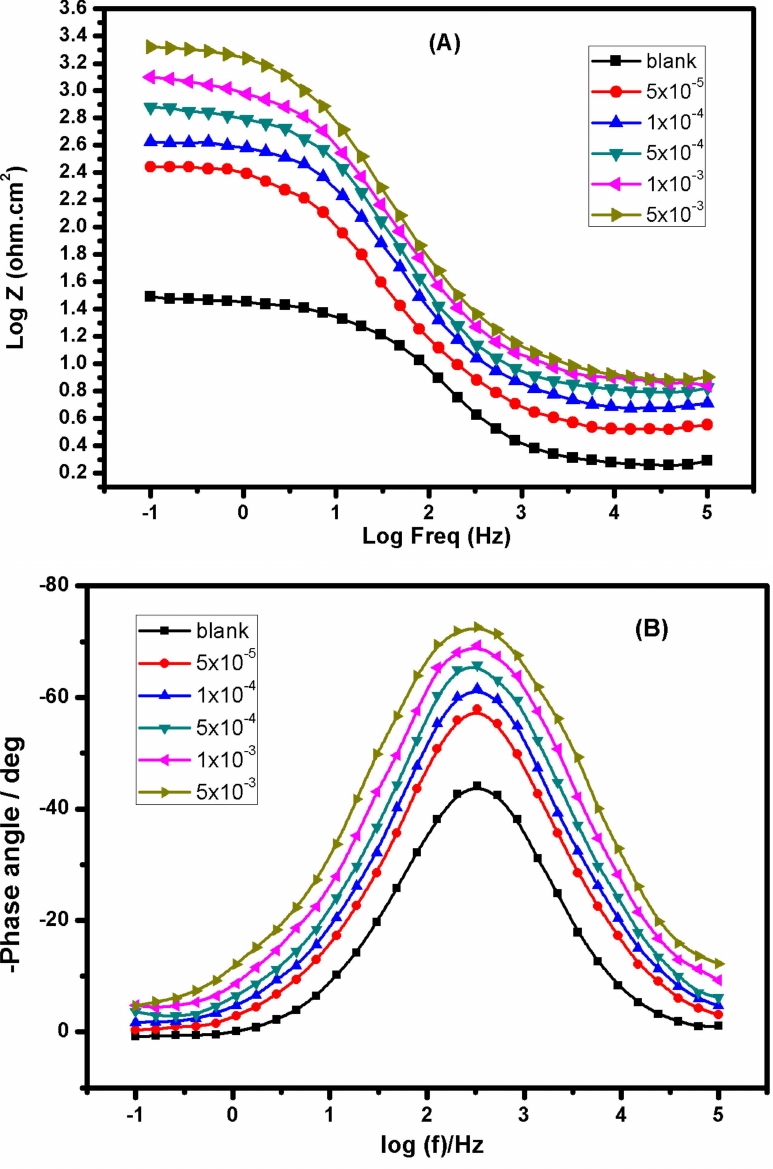
Figure 5. Bode ( A ) and phase angle ( B ) plots for mild steel in presence of 1.0 M HCl alone and containing different concentrations of BBMImIM ionic liquid at 25 ◦